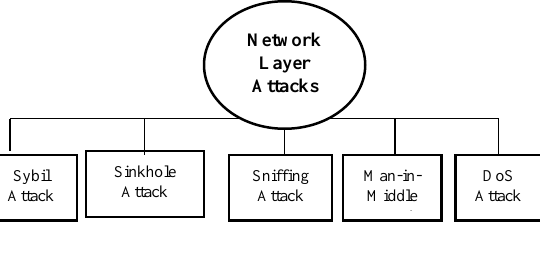
Figure 3. Network Layer